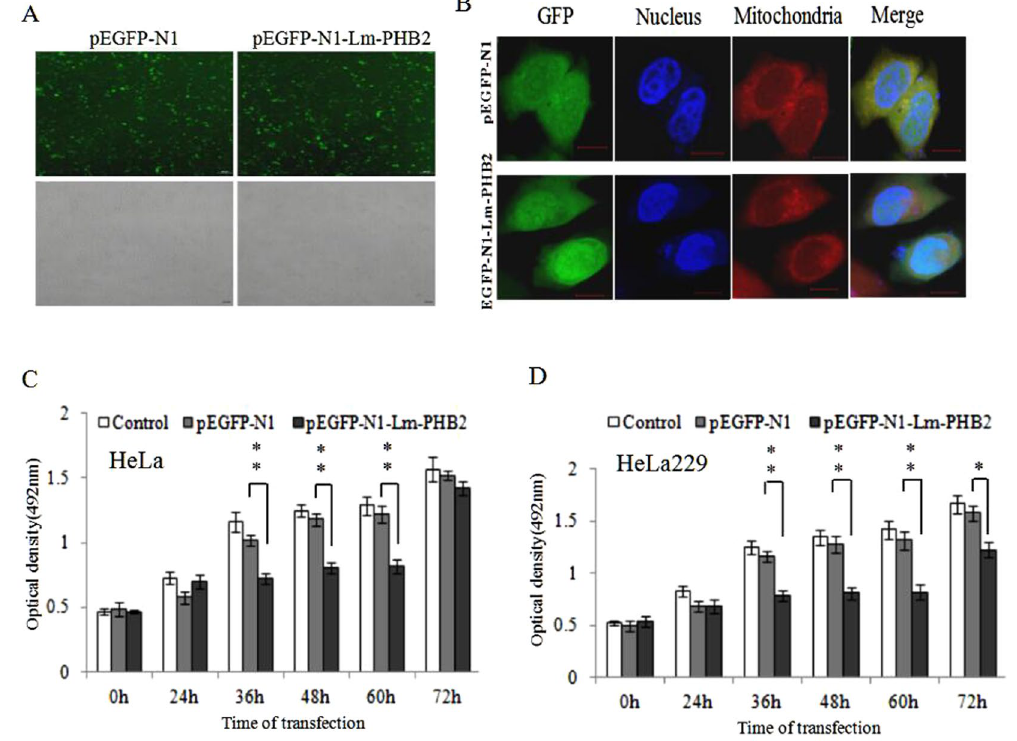
Figure 2. Effect of overexpression of Lm-PHB2 on the proliferation of human cervical cancer cells. ( A ) Transfer efficiency of HeLa cells after transfected with pEGFP-N1-Lm-PHB2 or pEGFP-N1 at 37 °C for 24 h. Scale bar, 100 μ m. ( B ) Subcellular organelles localization of Lm-PHB2 protein in HeLa cells visualized by confocal microscopy with Hoechst33258 (blue, nucleus), GFP (green, Lm-PHB2), and MitoTracker Red (red, mitochondria). Scale bar, 10 μ m. ( C , D ) HeLa and HeLa 229 cells were transfected with pEGFP-N1-Lm-PHB2 or pEGFP-N1 at 37 °C for 24 h, 36 h, 48 h, 60 h or 72 h and the viability of the cells was determined by MTT assay. Data are the means ± SDs from three experiments, each carried out in triplicate.‘ * ’and ‘ ** ’ indicate significantly different from cells transfected with pEGFP-N1 at the P < 0.05 and P < 0.01 levels,